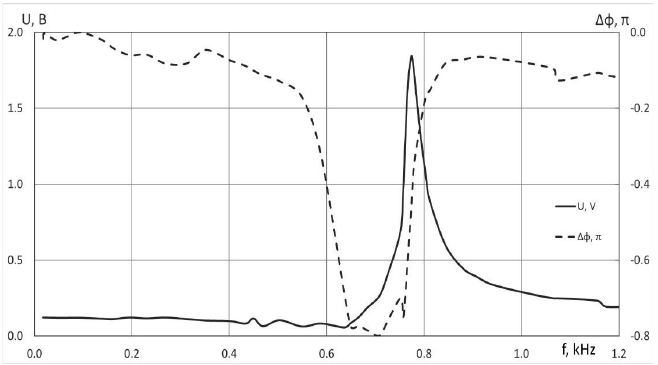
Figure 6. Induced piezoelectric signal (solid line) and its phase shift (dashed line) vs. exitation fre- quency.